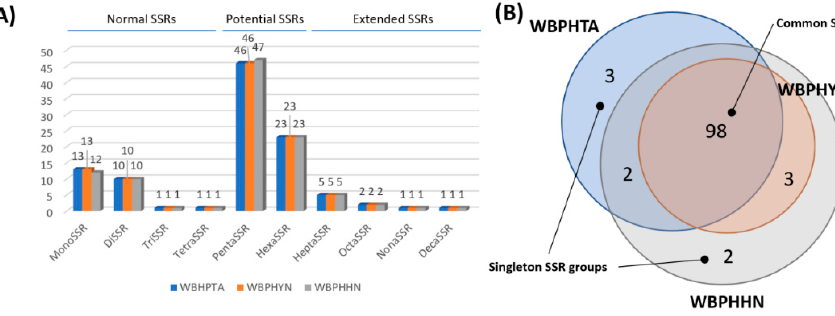
Figure 6. SSR comparison was identified from the three WBPH mitogenomes. ( A ) The X -axis indicates SSR types and Y -axis shows the number of SSRs. Three colors, blue, orange, and grey, mean the three WBPH mitogenomes, WBPHHN, WBPHYN, and WBPHTA, respectively. ( B ) Vann diagram displays the classification of SSR groups identified from the three WBPH mitogenomes. Transparent blue-colored, red-colored, and grey-colored circles indicate the mitogenome of WBPHTA, WBPHHN, and WBPHYN, respectively. Numbers on the Vann diagram present a number of SSR groups.